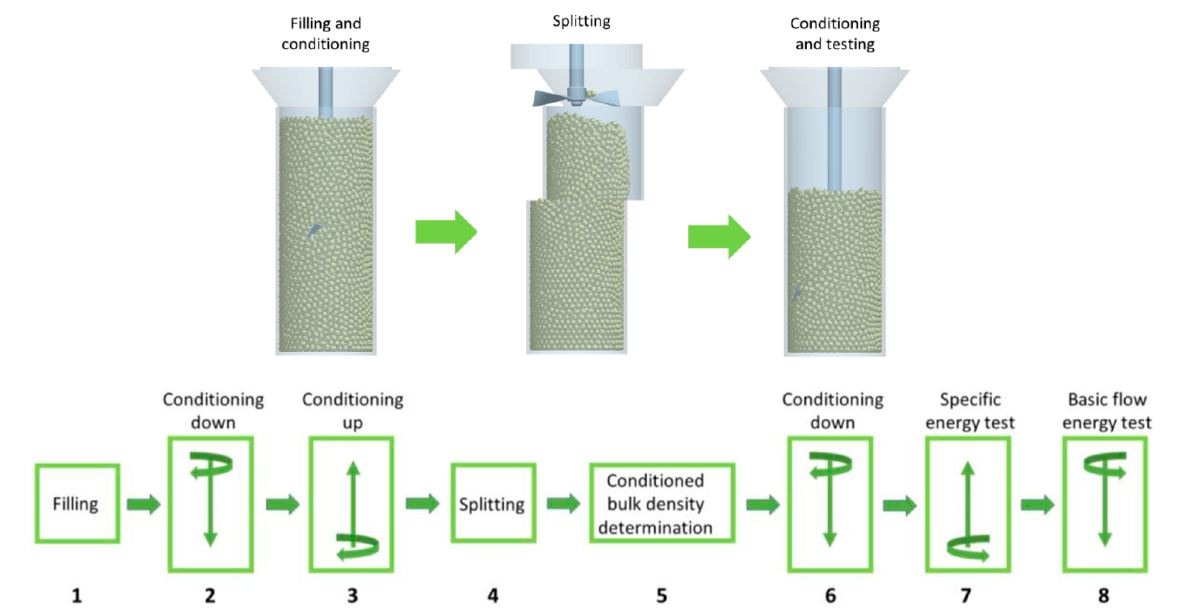
Figure 3. Cross-sections of the DEM model replicating the FT4 rheometer basic flow energy test and demonstrating the different stages of the procedure.